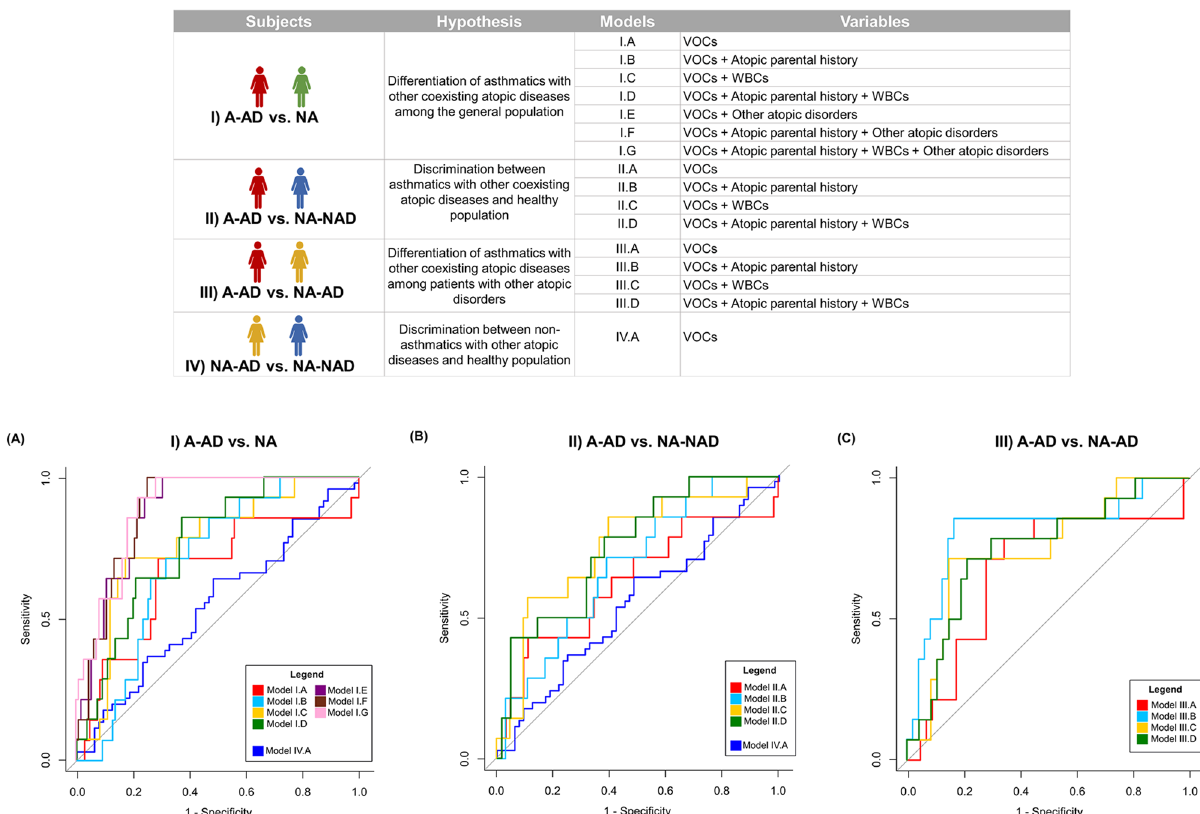
Figure 5. The constructed models. Top panel. Characteristics of the constructed models. (WBCs: white blood cell counts). Bottom panel. Receiver operator characteristic (ROC) curves of the constructed models. ( A ) ROC curves for discriminating between A-AD (asthmatics with other coexisting atopic diseases) and NA (non- asthmatics). ( B ) ROC curves for discriminating between A-AD and NA-NAD (non-asthmatic without atopic diseases). ( C ) ROC curves for discriminating between A-AD and NA-AD (non-asthmatic with other atopic